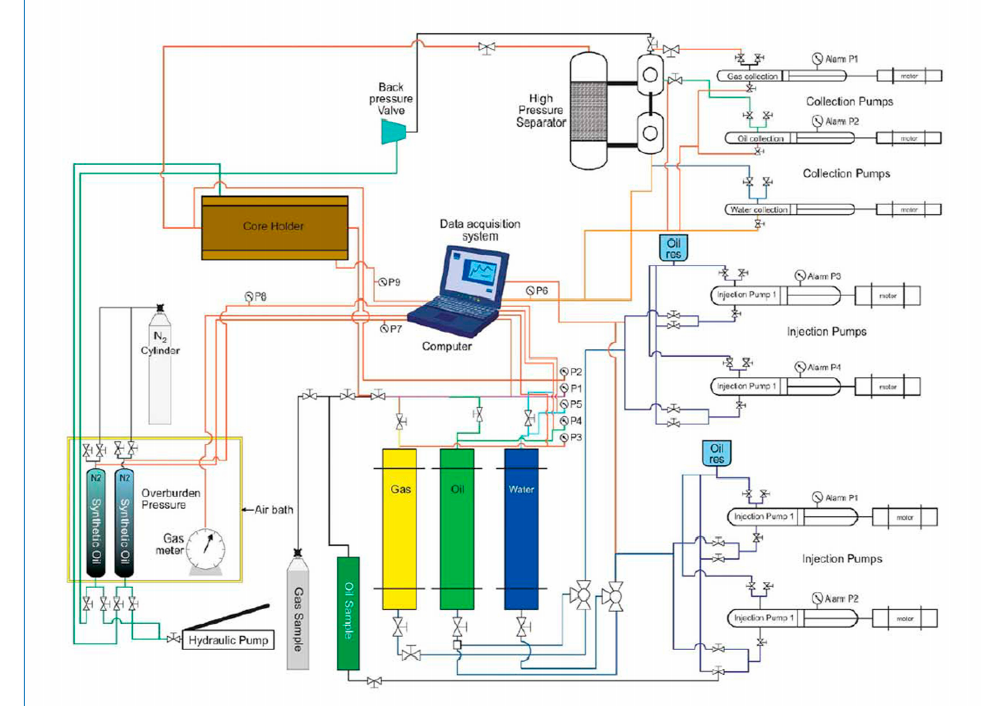
Figure 5. Core flooding experimental setup.